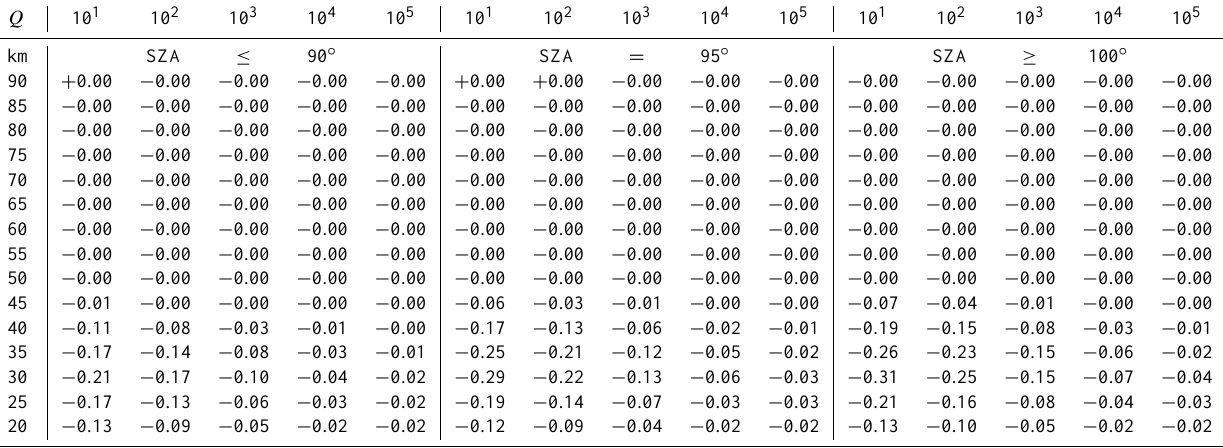
/Q for October NH. 2 O 5